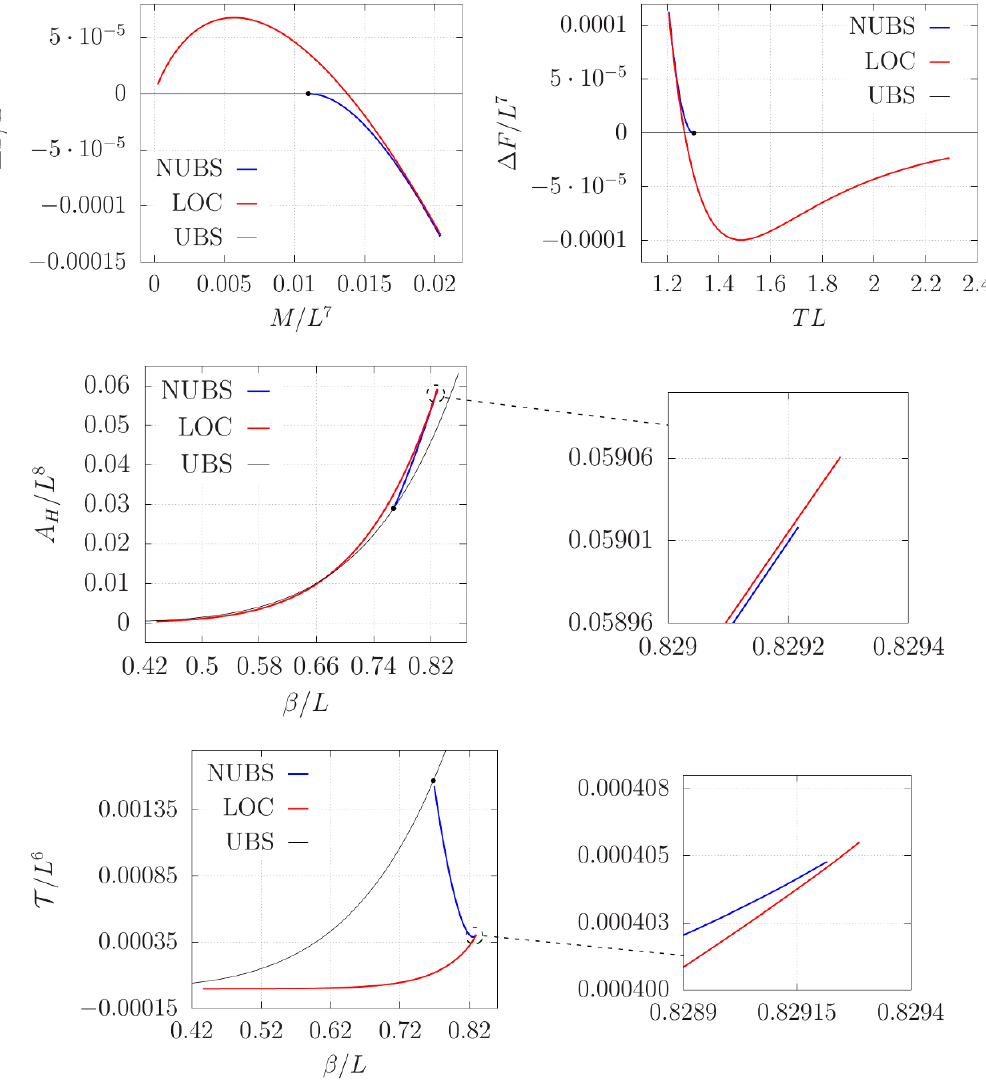
Figure 3 . Phase diagram in the microcanonical (top left) and canonical (top right) ensembles respectively for the three di(cid:11)erent families of KK black objects in D = 10. These plots reproduce and complete those shown in the appendix of [36]. Dimensionless horizon area A H =L 8 (middle) and tension T =L 6 (bottom) as a function of the dimensionless ratio (cid:12)=L . The GL critical point is indicated with a solid black disc. The dimensionless mass and relative tension plots are very similar to the ones shown